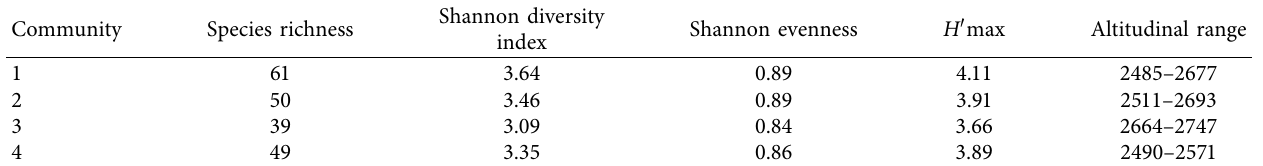
Figure 5: Dendrogram of the vegetation data obtained from hierarchical cluster analysis. Table 3: Shannon–Wiener indices, species richness, and evenness of the plant communities.